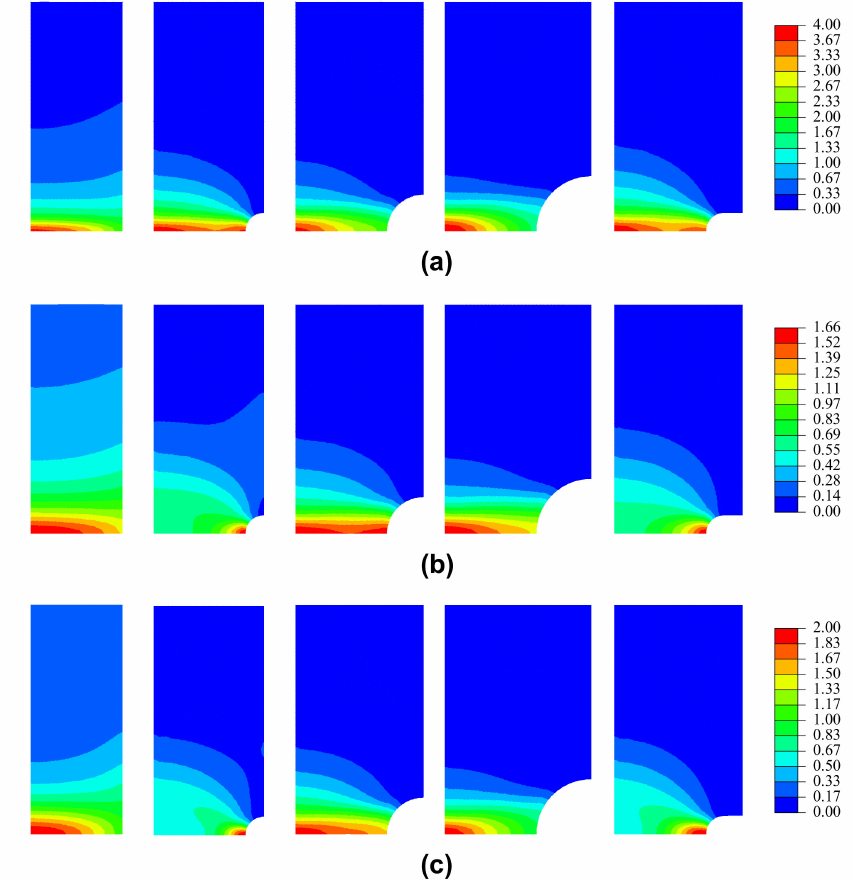
Figure 9. Contour of VGI index at fracture initiation in steel specimens, ( a ) RT, ( b ) 800 ◦ C-AC, and ( c ) 800 ◦